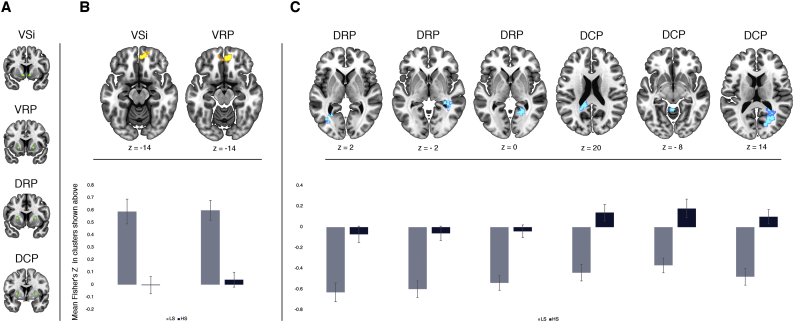
Statistical parametric maps showing (A) relevant seed regions, as well as (B) decreased positive and (C) decreased negative functional connectivity in high (HS) vs low (LS) schizotypy subjects, by seed, and corresponding mean Fisher's Z-values by group. Error bars in graphs represent standard error of the mean.